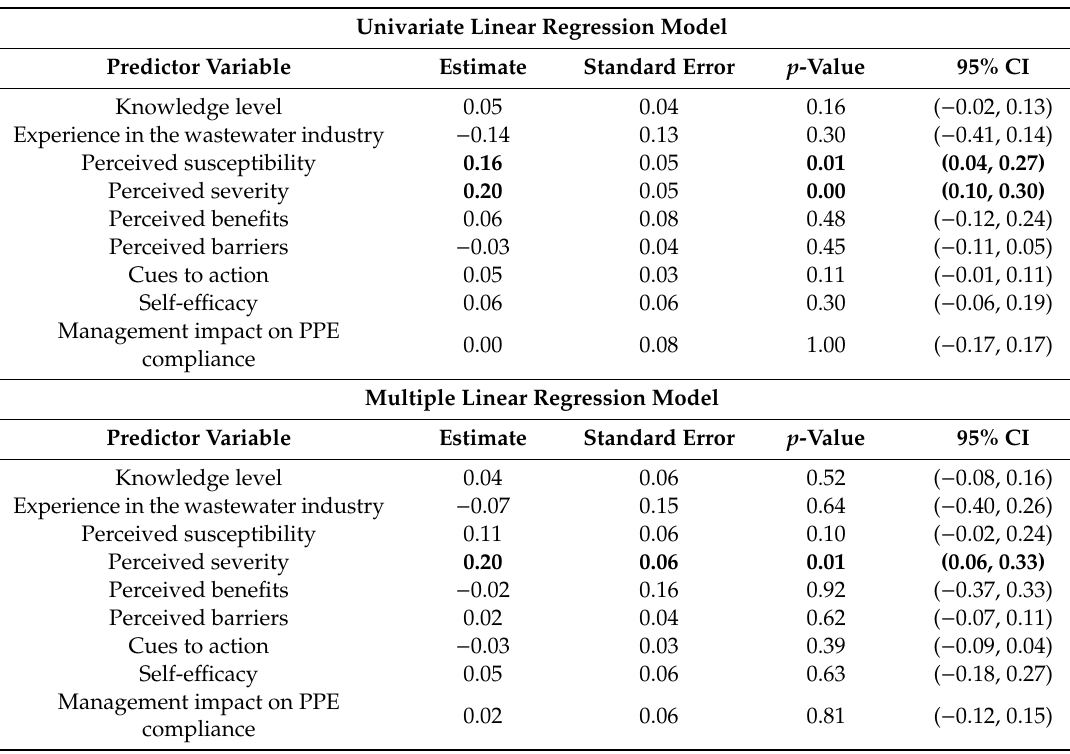
Table 5. Univariate and multiple linear regression analysis to determine which variables may increase PPE compliance among wastewater workers.